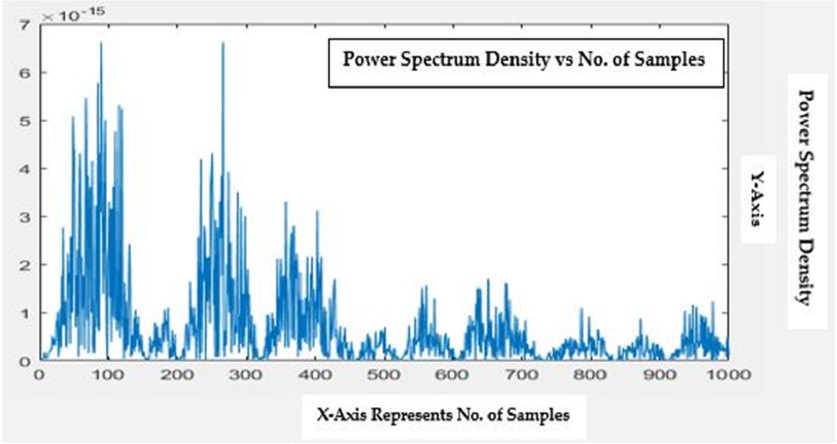
Figure 9. Healthy motor phase: a feature point representation with 1000 samples. (Figures Titled-300 dpi).